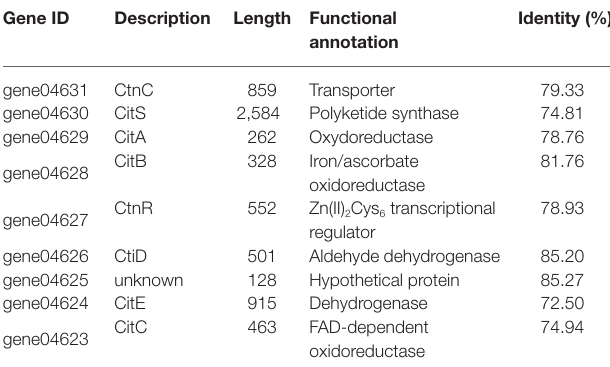
TABLE 4 | The citrinin biosynthesis gene